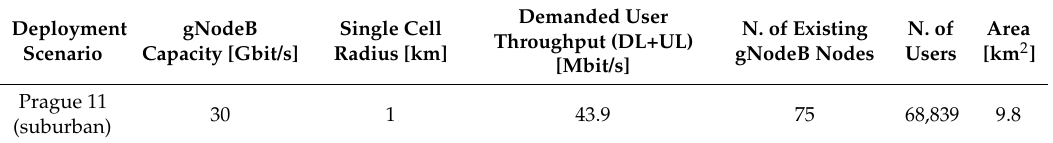
Table 7. Prague 11 deployment